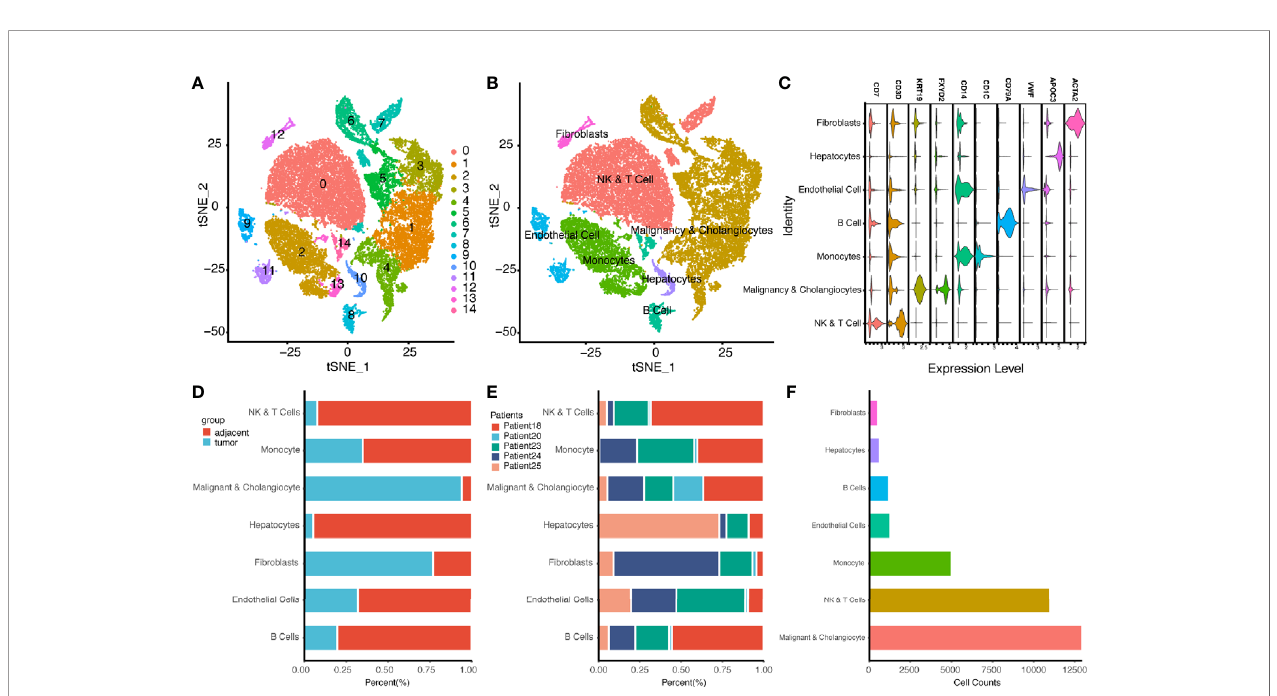
FIGURE 4 | Single Cell Atlas of CCA Patients According to Dataset GSE138709. (A, B) Cell clusters for GSE138709 of fi ve CCA patients. (C) Cell markers for clusters ’ annotation. (D) Portions of adjacent and tumor tissues in different cell clusters. (E) Patient portions in different cell clusters. (F) Numbers for cell clusters in dataset after fi